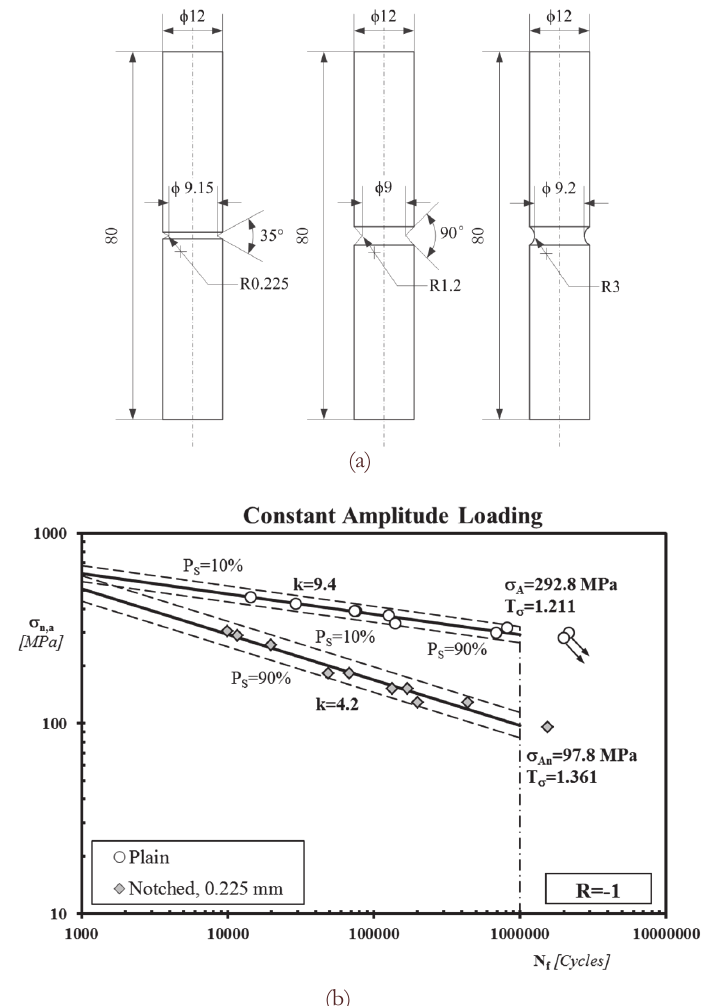
Figure 1: (a) Geometries of the tested notched samples (dimensions in millimetres). (b) Fatigue results generated under CA uniaxial fatigue loading